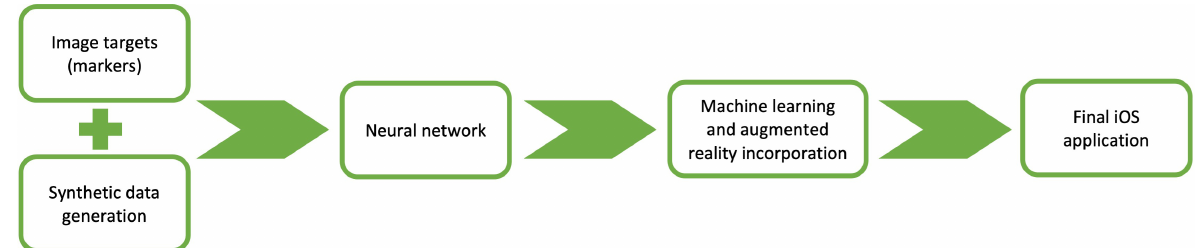
Figure 5. The proposed method summarisation where the machine learning module is incorporated with the augmented reality module.